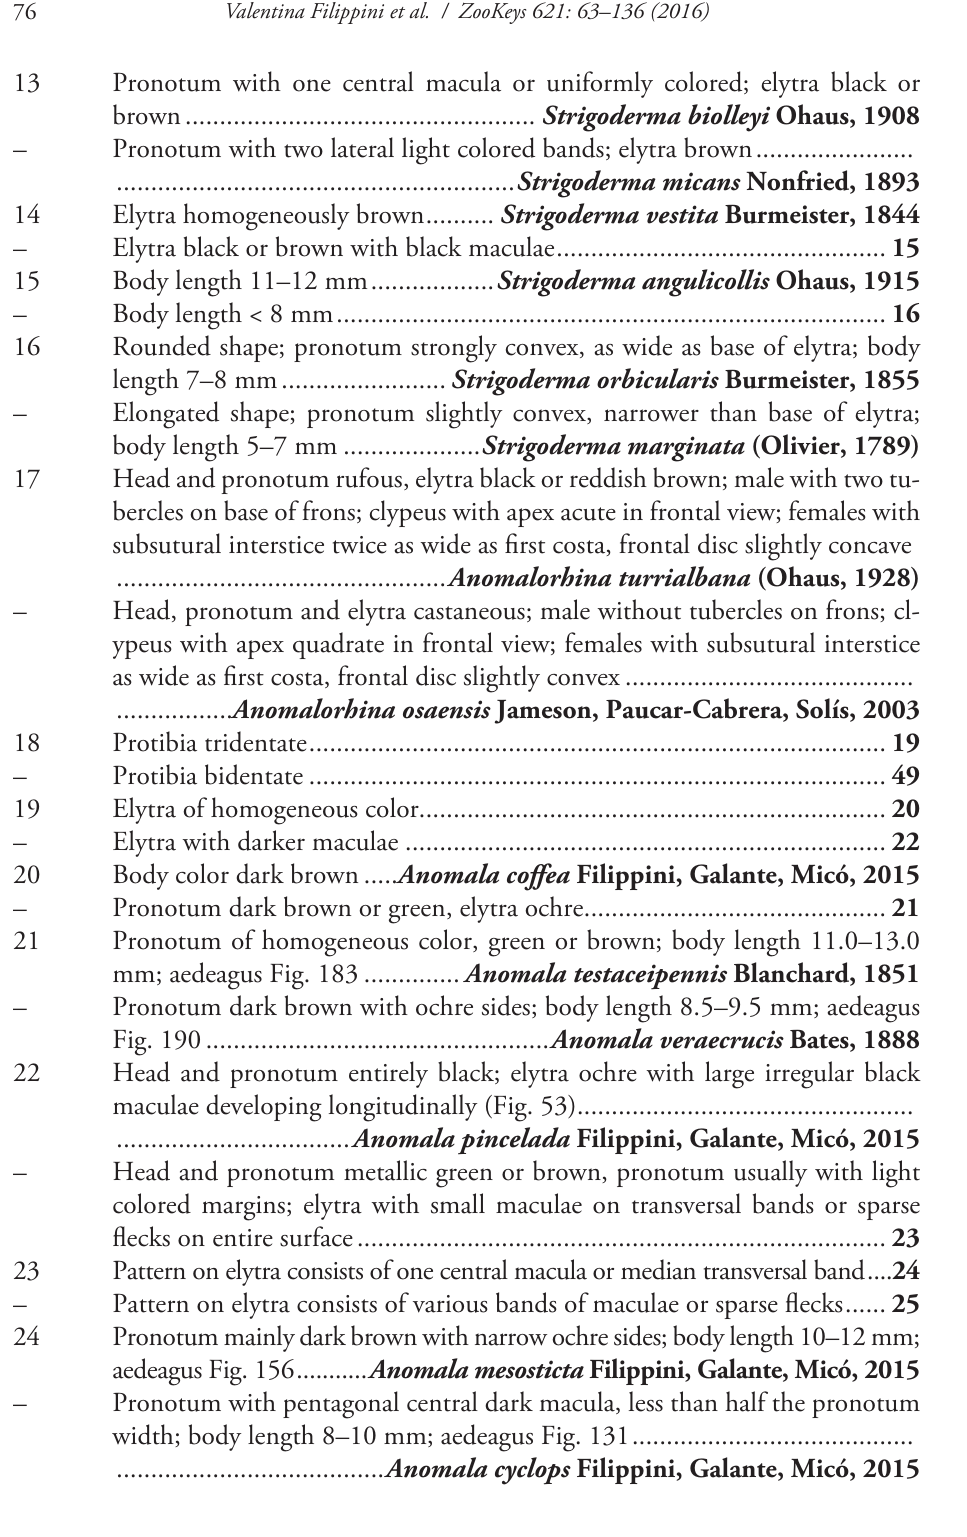
Pronotum with one central macula or uniformly colored; elytra black or